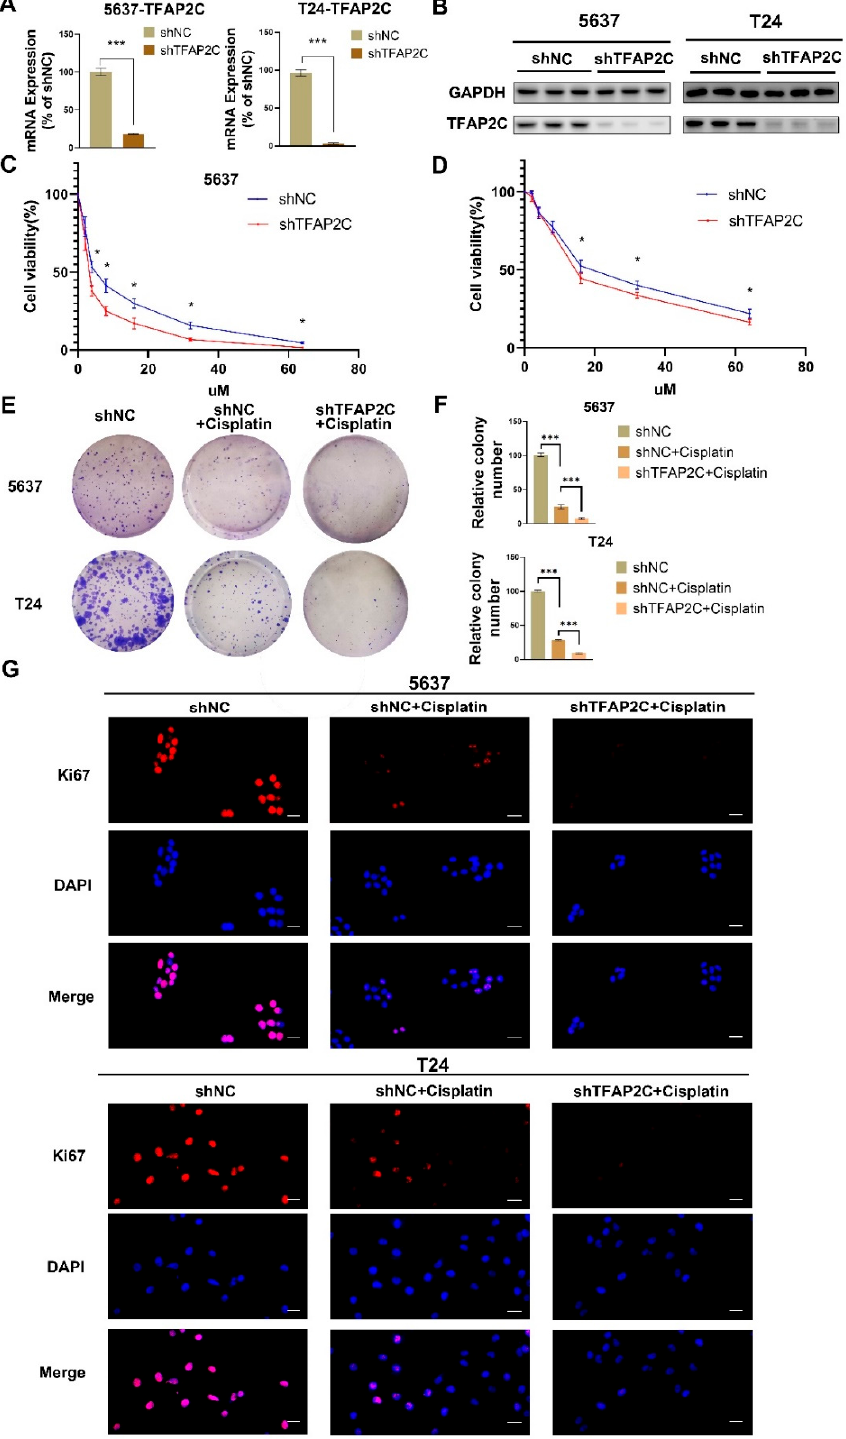
Figure 2. TFAP2C knockdown enhances the anti-tumor effects of cisplatin. ( A , B ) The knockdown efficiency of TFAP2C was confirmed by qRT–PCR and WB analysis. ( C , D ) CCK-8 assays were performed to detect cell viability following treatment with cisplatin. TFAP2C knockdown increased the suppression rate of cisplatin in 5637 and T24 cells. ( E , F ) Representative images of the colony formation assay. ( G ) Representative immunofluorescence images of Ki67 staining in 5637 cells and T24 cells. Scale bars, 20 µm. Data represent the mean ± standard deviation (SD) of three independent experiments (* p < 0.05, *** p < 0.001, ns, not significant).